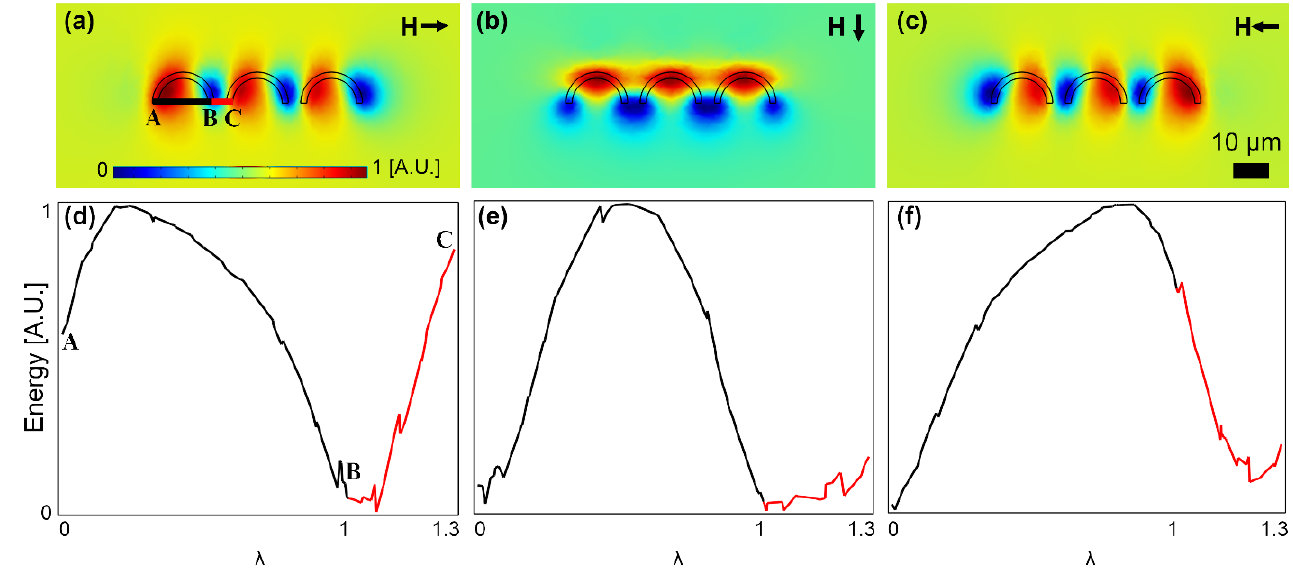
Figure 9. The particle transport on a pure C-shaped magnetic track is studied. ( a – c ) The potential energy distributions for three sequential magnetic field directions are illustrated. ( d – f ) The energies along the lines AB and BC (see ( a )) for the field directions of ( a – c ) are plotted in ( d – f ), respectively. The small black arrows stand for the magnetic field directions. The field is rotating clockwise, and the steps ( a – c ) are 90°. The energies are plotted at the center of a particle with a radius of 2.5 µm. The blue and red areas indicate the regions with low and high potential energies, respectively.